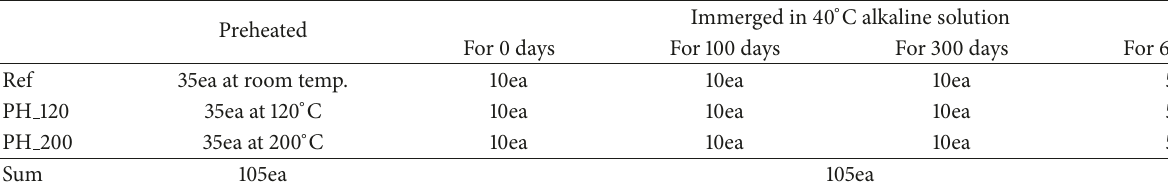
Table 1: Outline of experimental program.